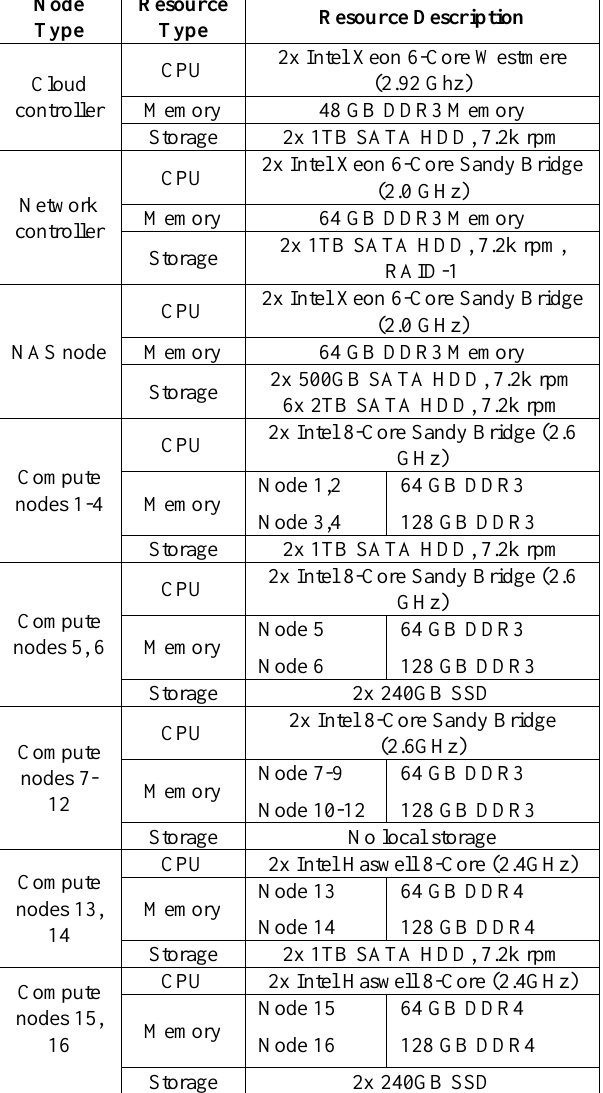
Table 1. Cloud testbed physical nodes.